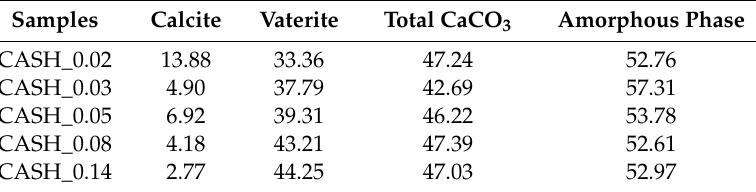
Figure 6. XRD analysis of C-(A)-S-H after carbonation for 28 days.